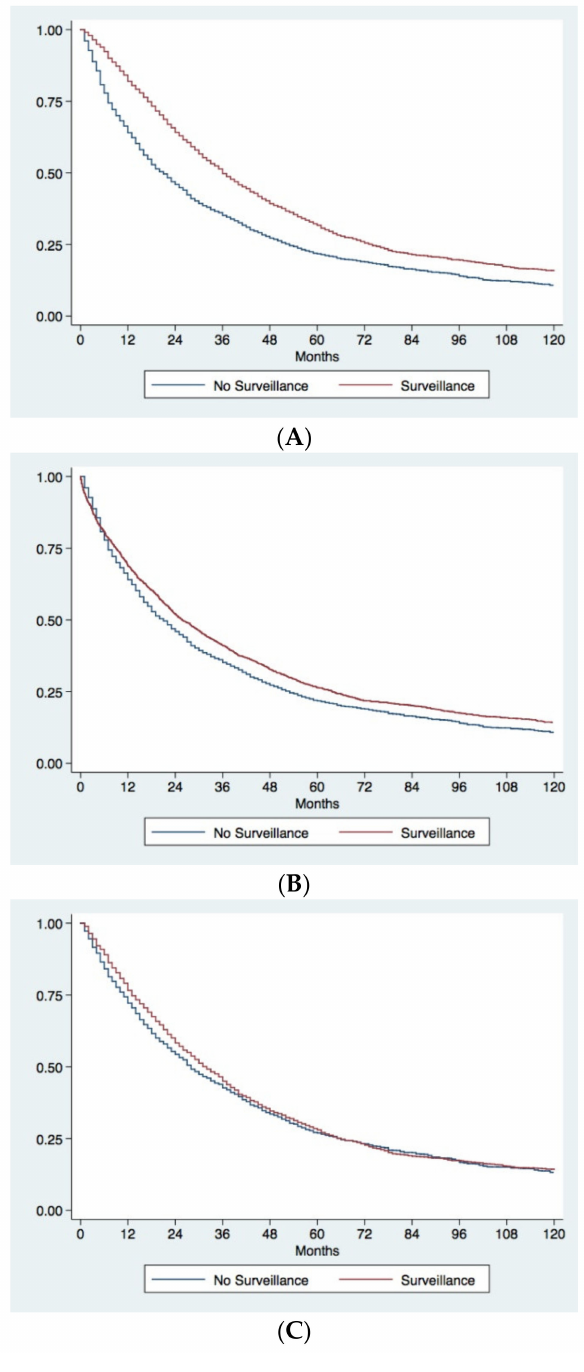
Figure 2. Kaplan–Meier survival curves comparing surveillance and no surveillance groups. ( A ) Observed survival of patients diagnosed under surveillance or with a casual/symptomatic diagnosis. Patients diagnosed under surveillance demonstrated a significantly longer survival ( p < 0.0001). ( B ) Observed survival of patients with casual/symptomatic diagnosis compared to corrected survival in surveilled patients. Surveillance significantly improves prognosis of patients even after correction for the lead-time bias ( p = 0.0008). ( C ) Comparison of survival between surveilled and not surveilled patients after adjustment for adjustment for confounders with IPW. The two groups of patients showed similar survival ( p =